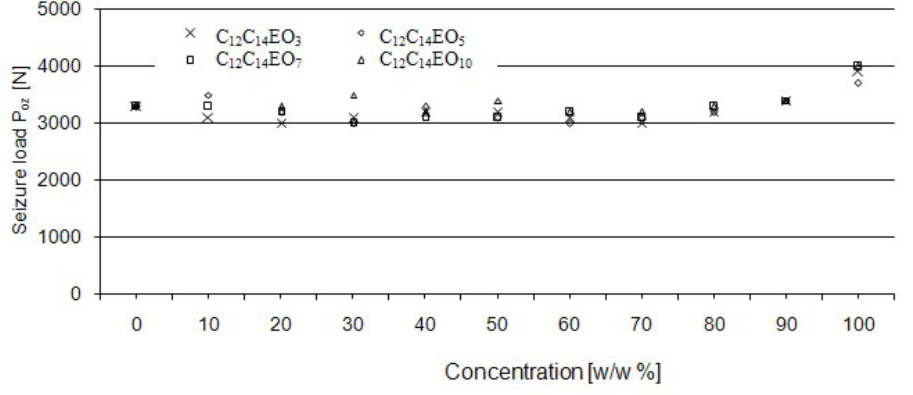
-C EO , 5–C -C EO , 7–C -C 12 14 3 12 14 5 12 14